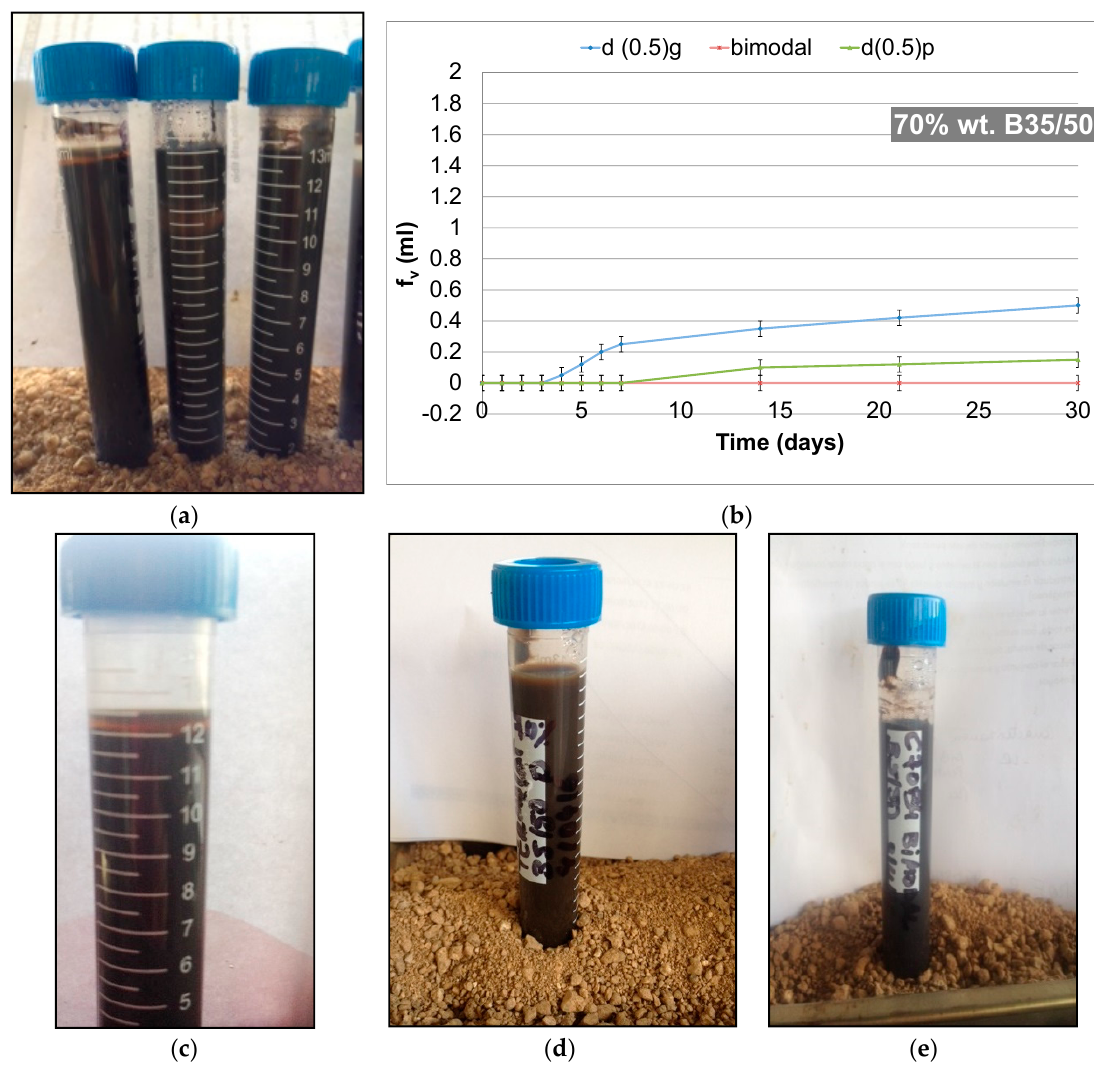
Figure 9. Emulsions of 70 wt. % B35/50: ( a ) global vision; ( b ) sedimentation curve; ( c ) monomodal d(0.5) l ; ( d ) monomodal d(0.5) s ; ( e ) bimodal emulsion.